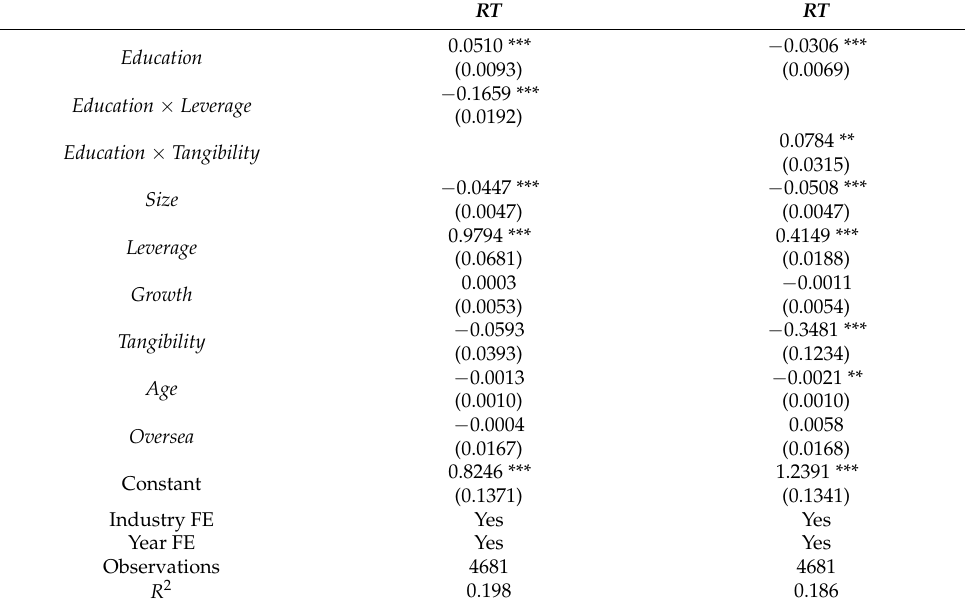
Table 6. The interaction between education and firm